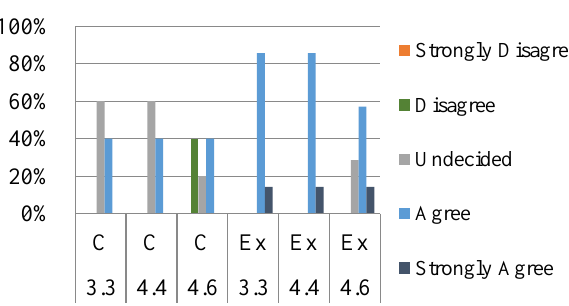
Figure 9. Highlights from the user-survey, overall group impressions. Questions focused on robot believability, before and after completion of the emotion guessing game and imitation sequences.